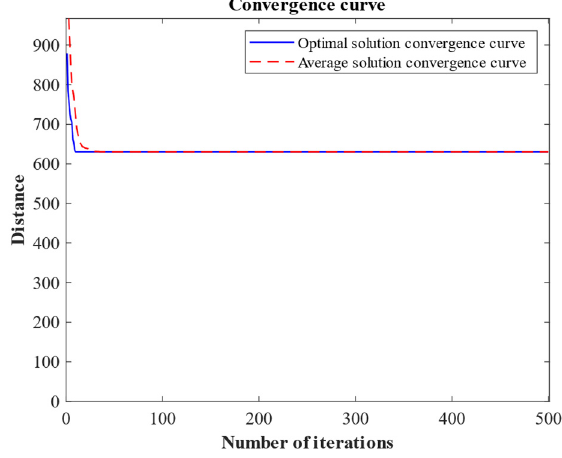
Figure 5. The optimization convergence curve of the cuckoo search algorithm when the number of locations to be visited is 10.